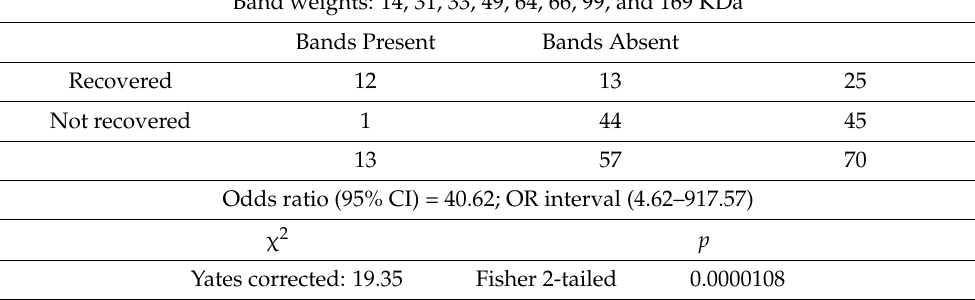
Table 2. Odds ratio values by the Yates chi-square test for all eight significant antigen strains of L. infantum considered together.